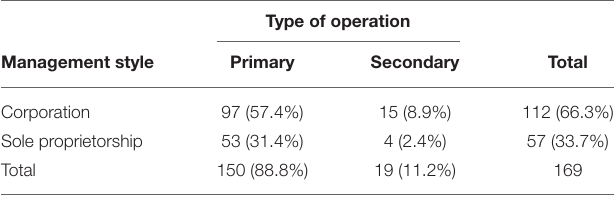
TABLE 2 | Attributes of responding clinics by management style and type of operation.